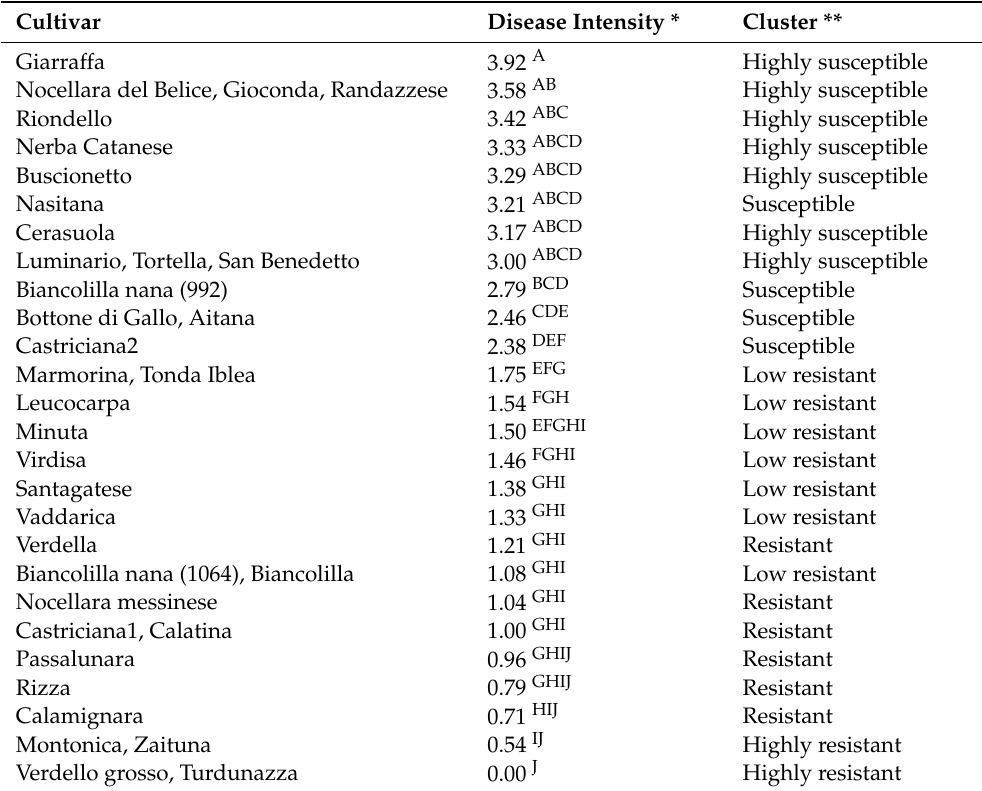
Table 1. Susceptibility to olive knot disease of 36 Sicilian cultivars located at the IOGC “Villa Zagaria” (Sicily, Enna province), revealed by visual assessment and according to disease intensity and cluster analysis. Cultivar Disease Intensity